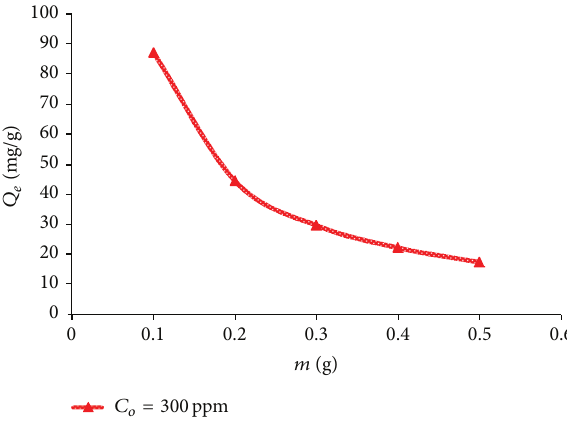
Figure 3: The effect of carbon dose for the uptake of methylene blue.